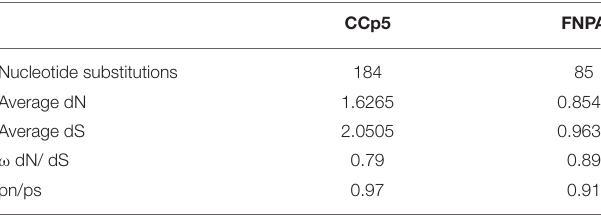
TABLE 3 | Polymorphism and average SNPs of the CCp5 and FNPA genes among different distinct B. bovis